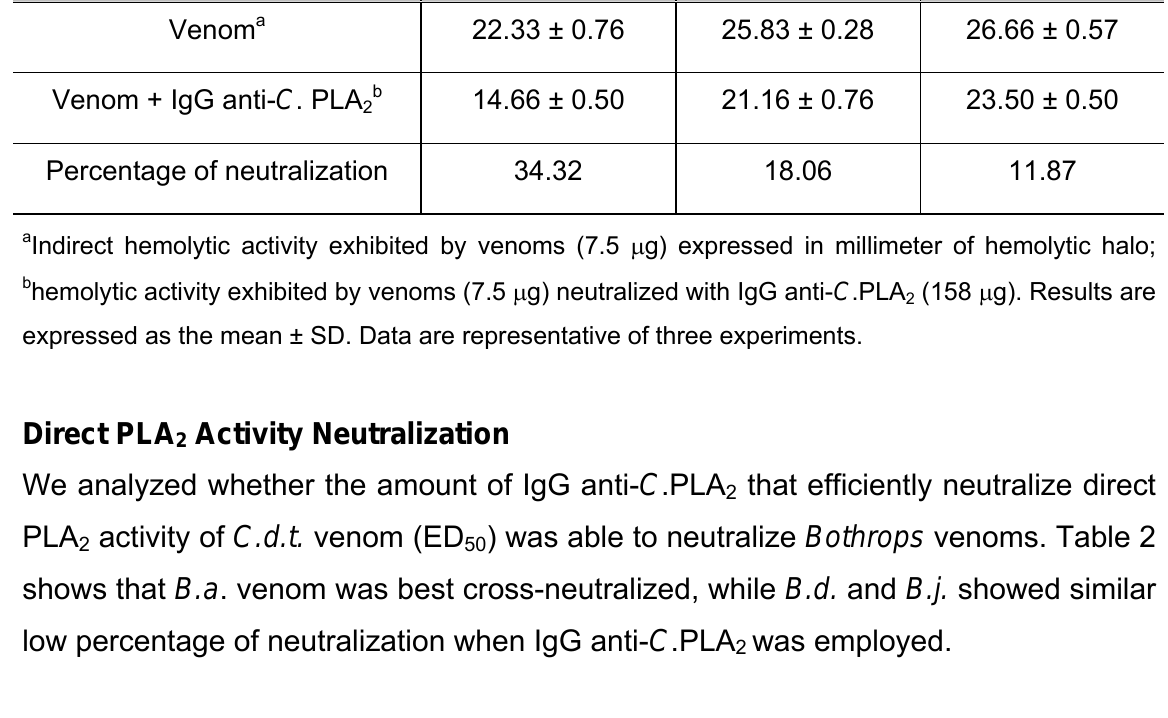
Table 2. Direct PLA